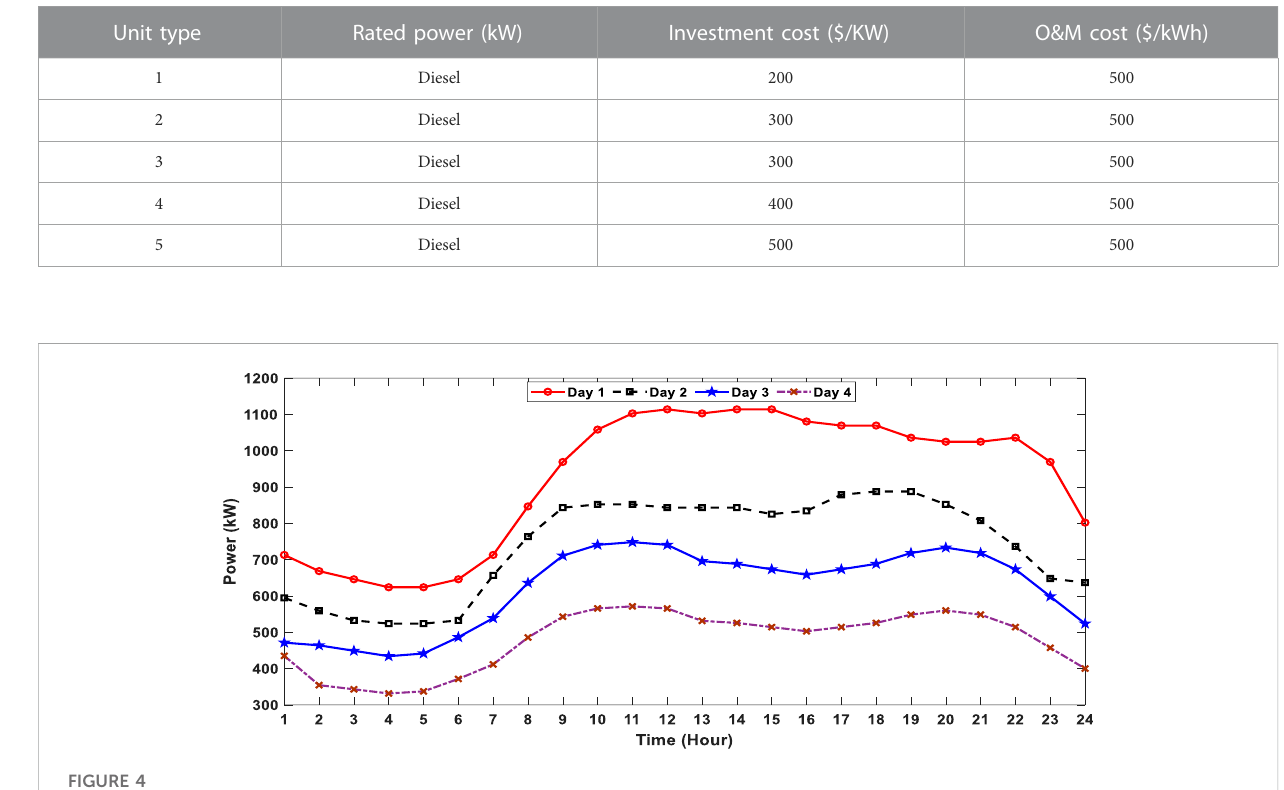
FIGURE 4 Typical 4-day forecasted load demand for the industrial microgrid (Cardenas et al.,